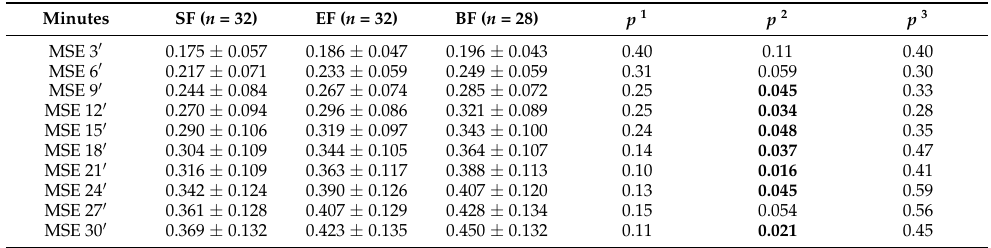
Figure 2. Minimum and maximum means of glucose levels by study group. Data are presented as mean ± SD. * p -value for differences between EF and BF groups. BF: breastfeeding; EF: experimental infant formula; SF: standard infant formula.